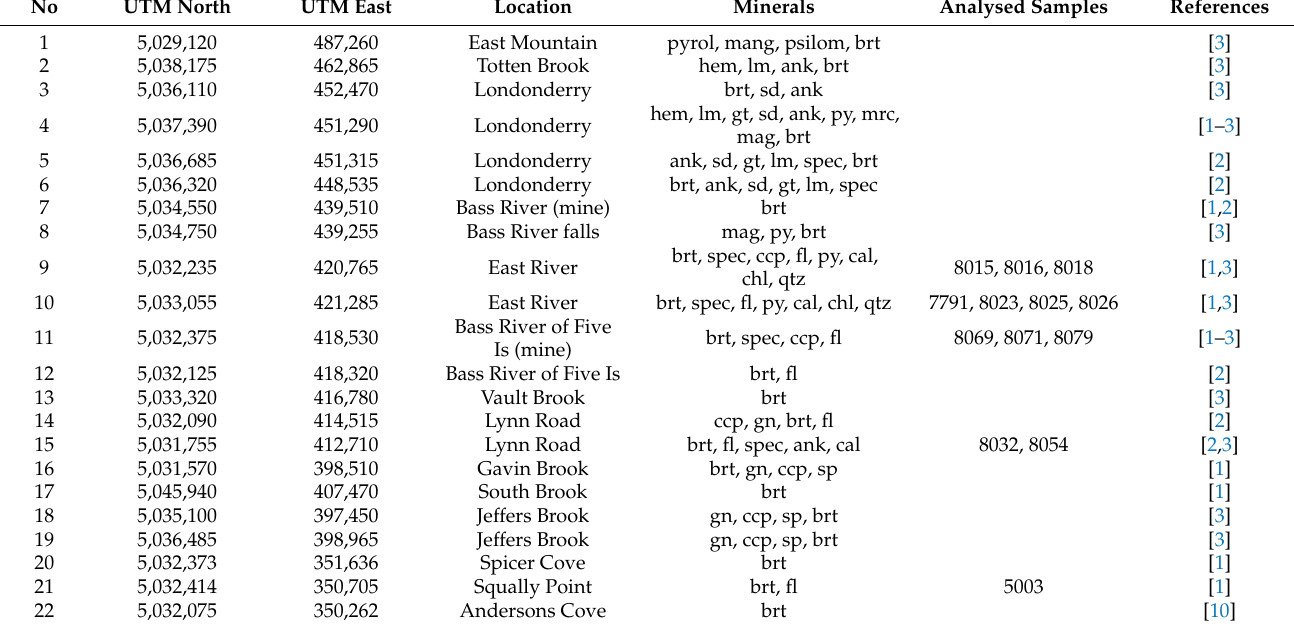
Mineral abbreviations follow Whitney and Evans [11] and pyrol = pyrolusite, mang = manganite, and psilom = psilomelane; minerals given in approximate order of